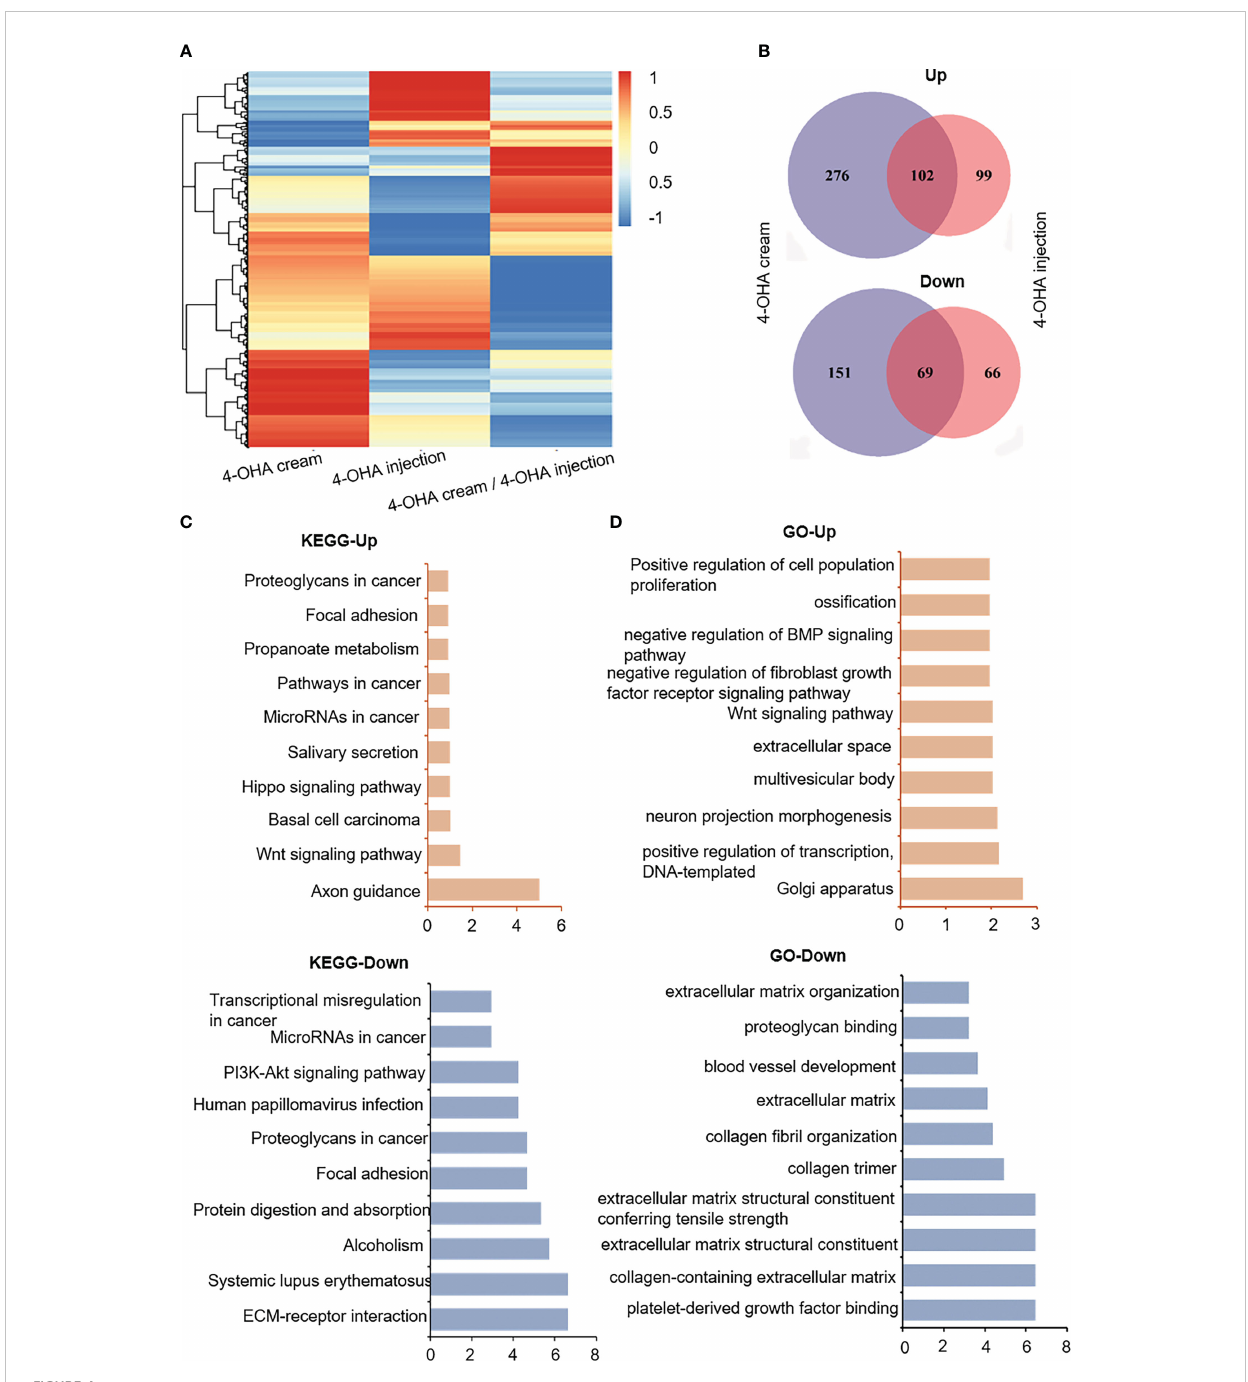
FIGURE 4 RNA-seq gene expression analysis of DMBA-induced mammary tumors treated with or without 4-OHA. (A) Heatmap of detected genes differentially expressed in the control and experimental group. (B) Venn diagram of 4-OHA-induced up-regulated or down-regulated DEGs in DMBA-induced tumors treated by 4-OHA cream or 4-OHA injection formulation. Kyoto Encyclopedia of Genes and Genomes (KEGG) (C) and Gene Ontology (GO) term (D) analysis of common differentially expressed genes between 4-OHA cream and 4-OHA injection